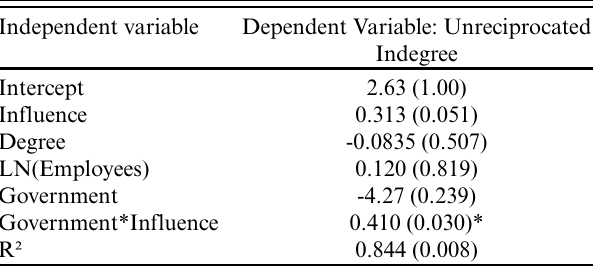
Table 3 . Quadratic assignment procedure (QAP) regression estimates (n = 60). α -value estimates in parenthesis (based on coefficient estimates for 10,000 permutations); * = sig. at 0.05